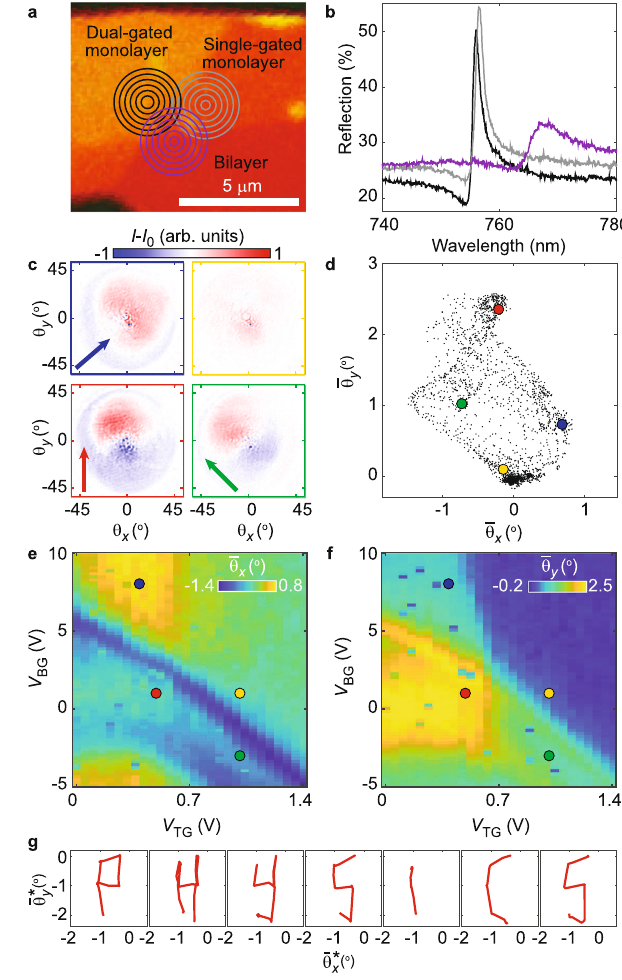
Fig. 3 Two-dimensional beam steering. a Zoomed-in optical image of device, indicating regions of monolayer and bilayer MoSe 2 , as well as gate coverage. By tuning the relative phase and amplitude of the re fl ection from the three regions, more intricate wavefront phase pro fi les can be achieved. b Re fl ection spectra from the dual-gated monolayer (black), single-gated monolayer (gray) and the bilayer (purple) in the intrinsic regime ( V BG = 0 V and V TG = 0.5 V). Since the resonance is red-shifted in the bilayer, it acts as a dielectric (non-resonant) re fl ector at the wavelengths used here. c Fourier images of re fl ected beam ( λ 0 = 754.1 nm) in the four regimes after subtracting re fl ection in the highly doped regime ( V BG = 10 V and V = 1.4 V). The beam is now steered in two dimensions. Red: when both TG monolayer resonances are red-shifted relative to λ 0 , their phase is higher than in the bilayer region, causing the beam to de fl ect upwards. Blue and green: when one of the monolayer resonances is kept red-shifted relative to λ fl ected towards that monolayer region. d Scatter plot of 0 , the beam is de the center-of-mass de fl ection ð (cid:1) θ x ; (cid:1) θ y Þ , with the points from ( c ) highlighted. The set of beam de fl ections now span a two-dimensional area. e , f Gate dependence of (cid:1) θ x ( e ) and (cid:1) θ y ( f ). While the gate dependence resembles that of the phase in Fig. 1g, (cid:1) θ x and (cid:1) θ y are now less coupled. g Center-of-mass de fl ection tracing out “ PHYSICS ” (rotated 148° counter-clockwise) by applying a sequence of gate voltage region where the edge of the bottom gate intersects a border between monolayer and bilayer MoSe 2 (Fig. 3a). Since the exciton resonance in bilayers is red-shifted to ~767 nm due to interlayer hybridization effects 31 (Fig. 3b), the bilayer acts as a non-resonant dielectric re fl ector, thus enabling control of the relative phase between the three regions. Figure 3c shows representative Fourier